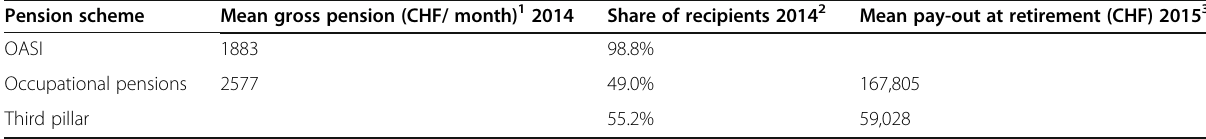
Table 1 Overview of old-age benefits in Switzerland Pension